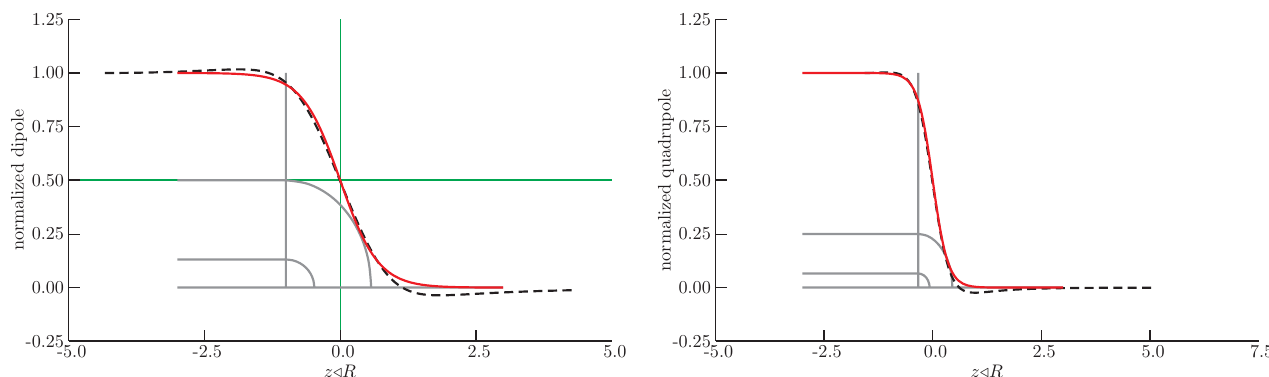
FIG. 31. (Color) Relative dipole field (left) and quadrupole field (right) near the magnet end. The dashed line is the field from TOSCA , while the solid line is our